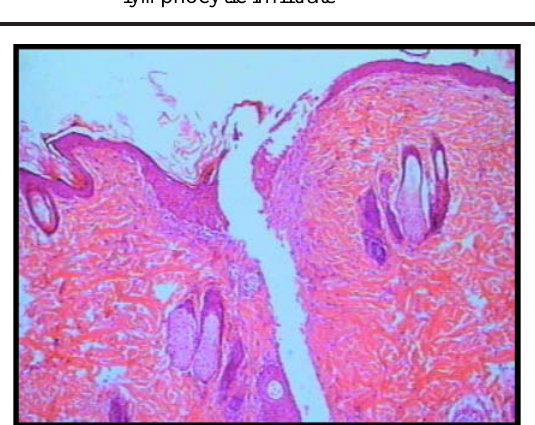
FIGURE 7 - Photomicrography with 40X lens (400X enlargement) of histological slice taken from the skin of a group C rat, stained with HE, showing giant foreign body cells and lymphocytic infiltrate